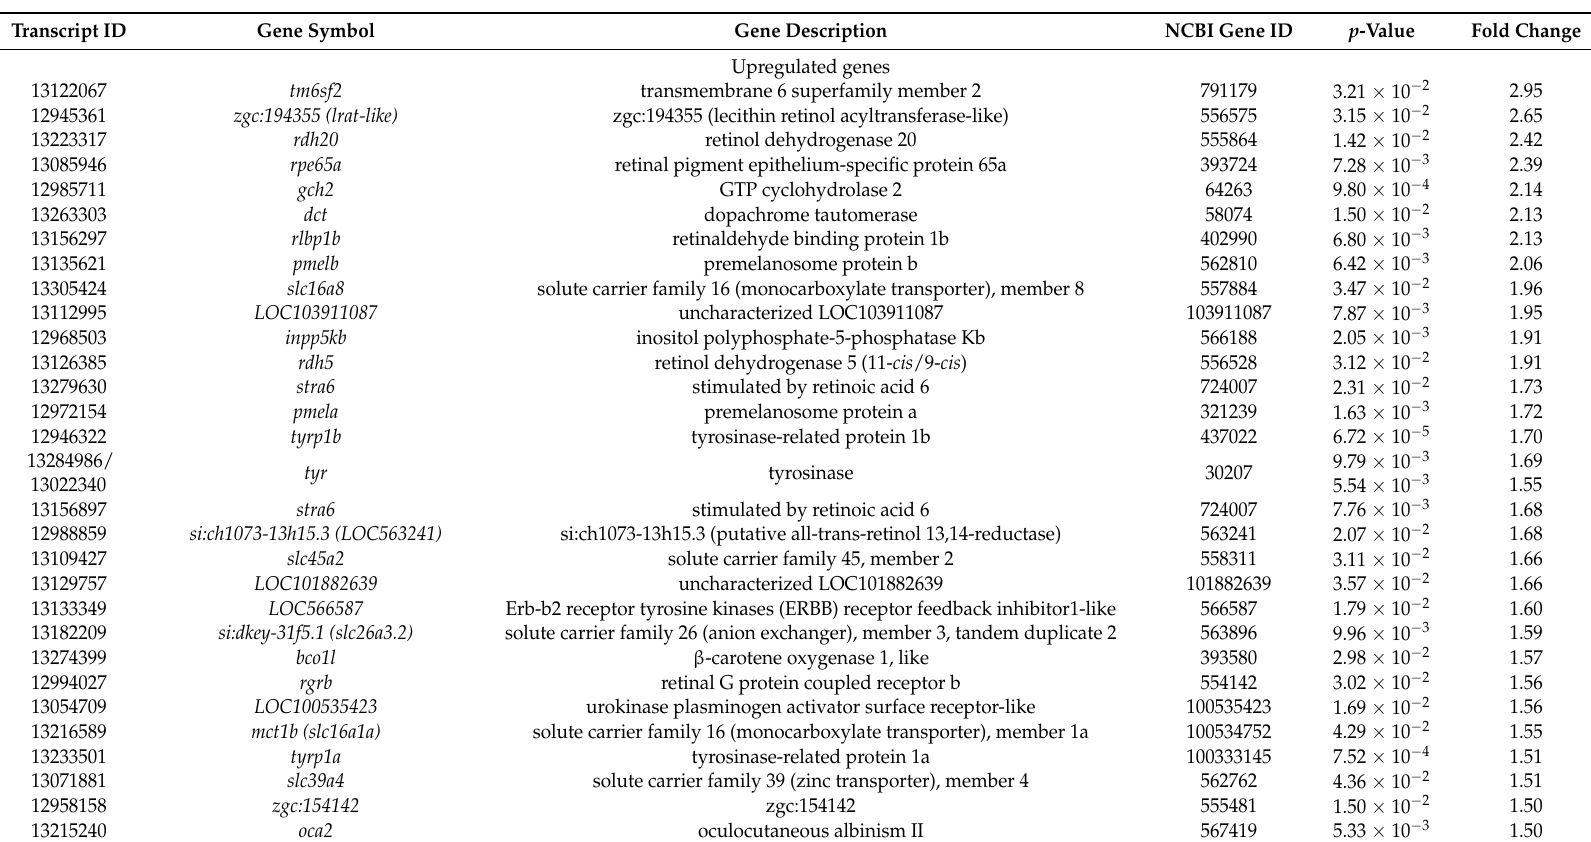
Table 1. Microarray analysis. List of differentially expressed genes top ranked based on fold-change that were differentially expressed, by microarray analysis, upon exposure of three days post-fertilization (dpf) zebrafish larvae to 500 µ g/L MCLR for four days, p ≤